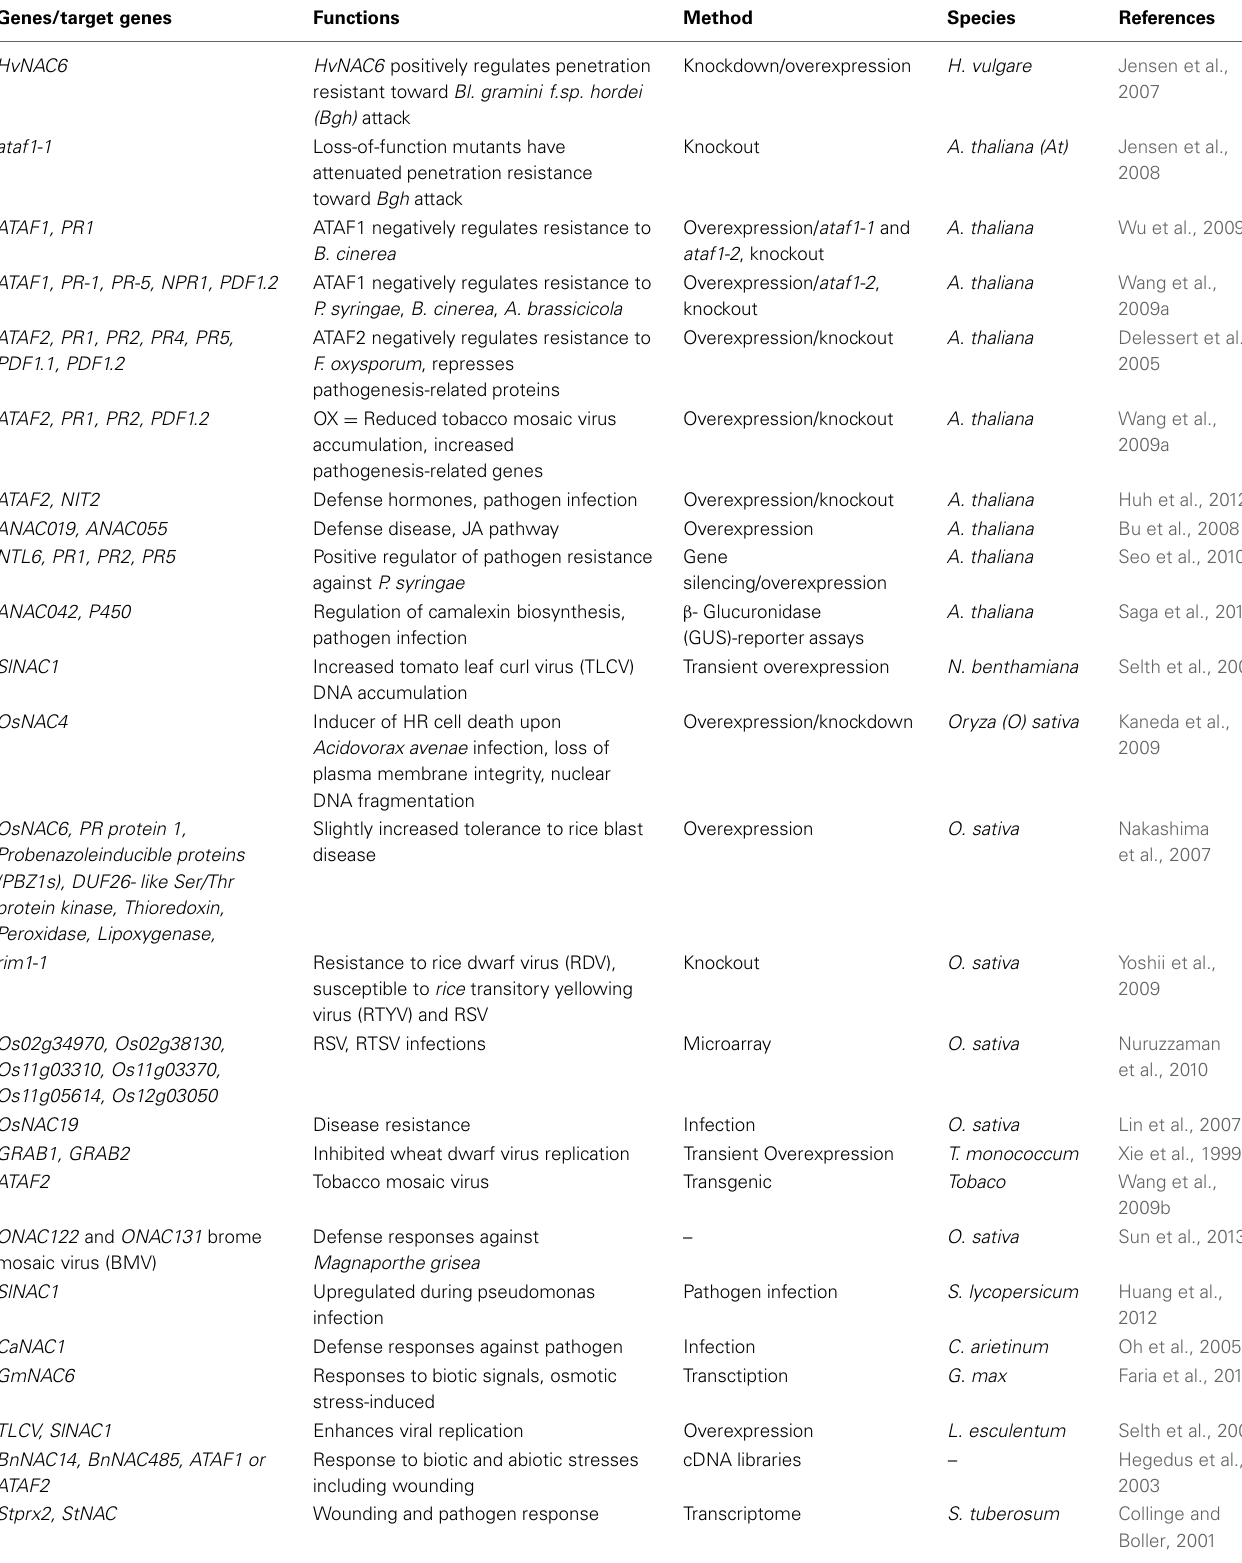
Table 1 | Function of NAC transcription factors in biotic